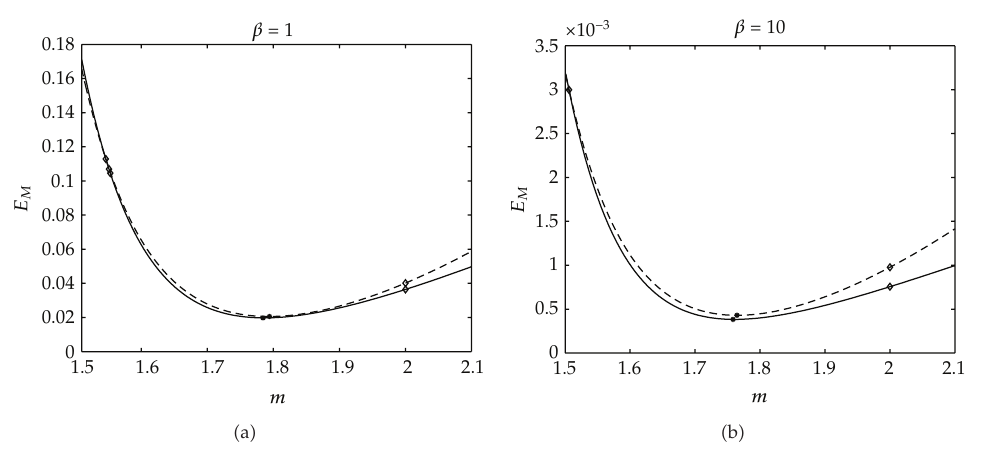
Figure 6: E M (cid:3) m (cid:4) for HBIM (cid:3) solid line (cid:4) and RIM (cid:3) dashed line (cid:4) , minimum errors shown as asterisks. (cid:3) a (cid:4) β (cid:8) 1, diamonds show errors for m (cid:8) 1 . 5531, m (cid:8) 1 . 5514 (cid:3) obtained by matching u x at x (cid:8) 0 (cid:4) , m (cid:8) 1 . 5463 (cid:3) CIM (cid:4) and m (cid:8) 2 . (cid:3) b (cid:4) β (cid:8) 10, diamonds show errors for m (cid:8) 1 . 5061, m (cid:8) 1 . 5060 (cid:3) matching u x at x (cid:8) 0 (cid:4) , m (cid:8) 1 . 5056 (cid:3) CIM (cid:4) and m (cid:8)